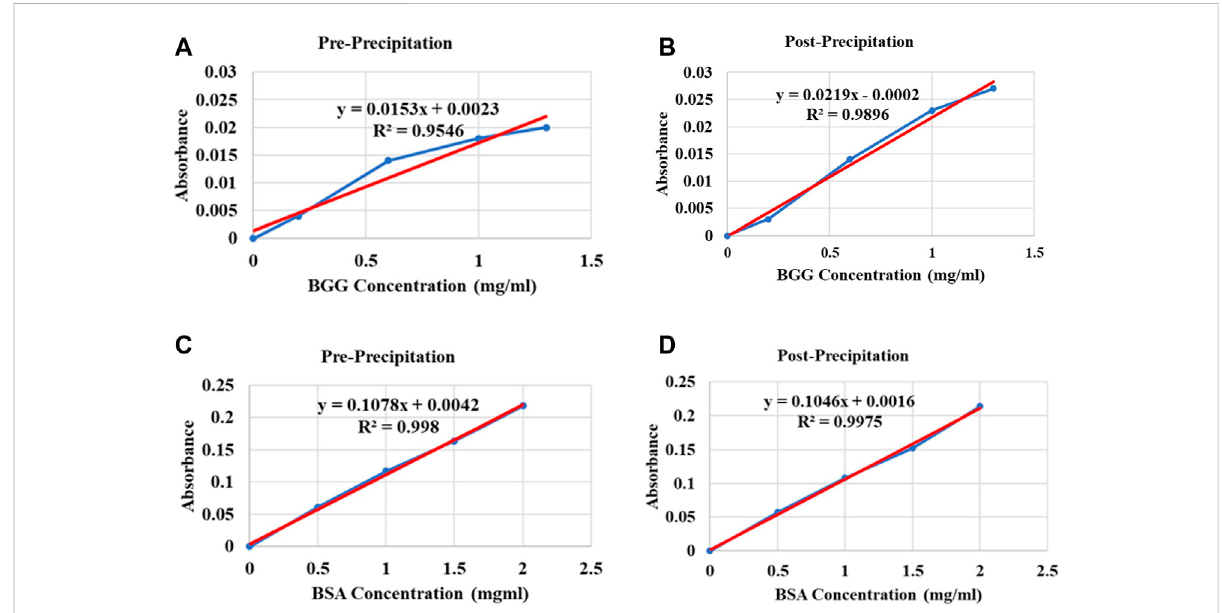
FIGURE 3 Standard curve plot examples of the Bio-Rad DC (Lowry) protein assay and the Pierce BCA protein assay illustrating variations between the two protein assay standard curve plots using Protocol 2 buffers. (A) Compatibility illustration of the Bio-Rad DC protein assay kit with Protocol 2 lysis buffer: pre-precipitation, (B) protein solubilization detergent: post-precipitation. Different concentrations of BGG protein as reference protein standarddilutedinlysisbufferandsolubilization detergentrespectively,wereplottedagainstabsorbancevalues. (C) Compatibilityillustrationof the Pierce BCA protein assay kit with Protocol 2 lysis buffer: pre-precipitation, (D) protein solubilization detergent: post-precipitation. Different concentrations of BSA protein as reference protein standard diluted in lysis buffer and solubilization detergent respectively, were plotted